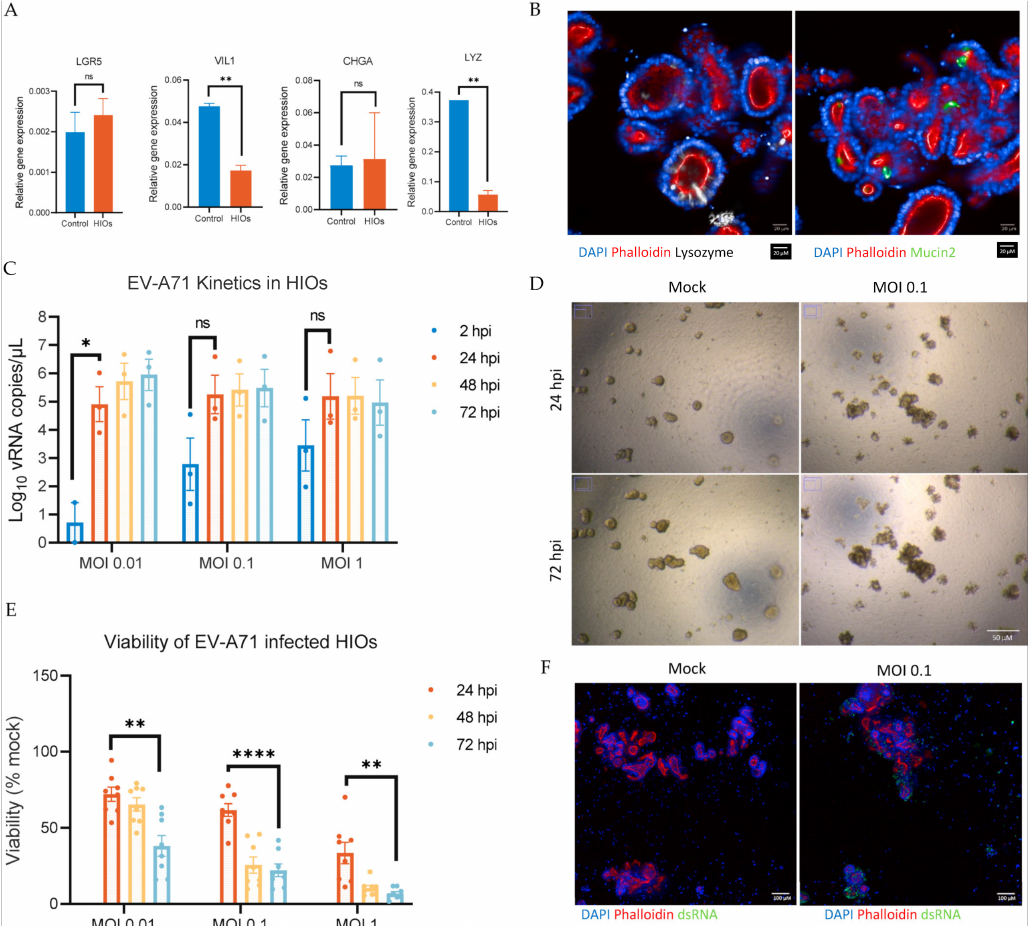
Figure 1. Characterization of the differentiation of human induced pluripotent stem-cells-derived small intestine organoids (HIOs) and Enterovirus A71 (EV-A71) replication kinetics in the derived HIOs and viability post infection. ( A ) Relative expression of total RNA of adult small intestine as